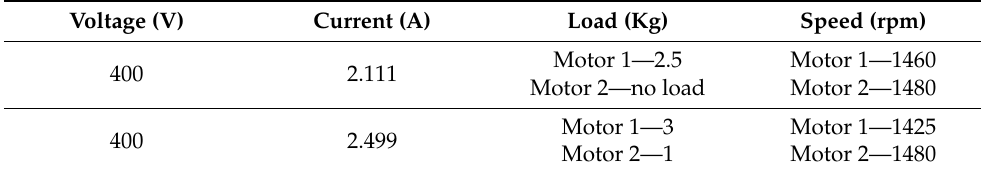
Table 7. Speed performance in unbalanced load